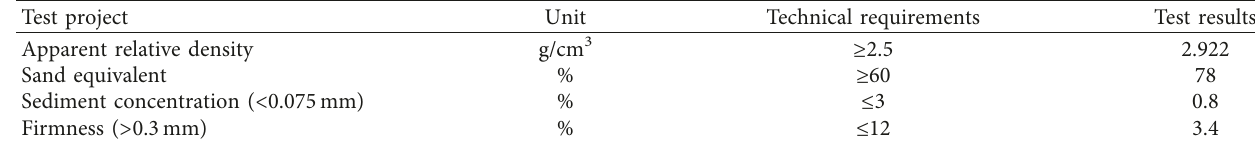
Table 3: Performance index of fine aggregate.